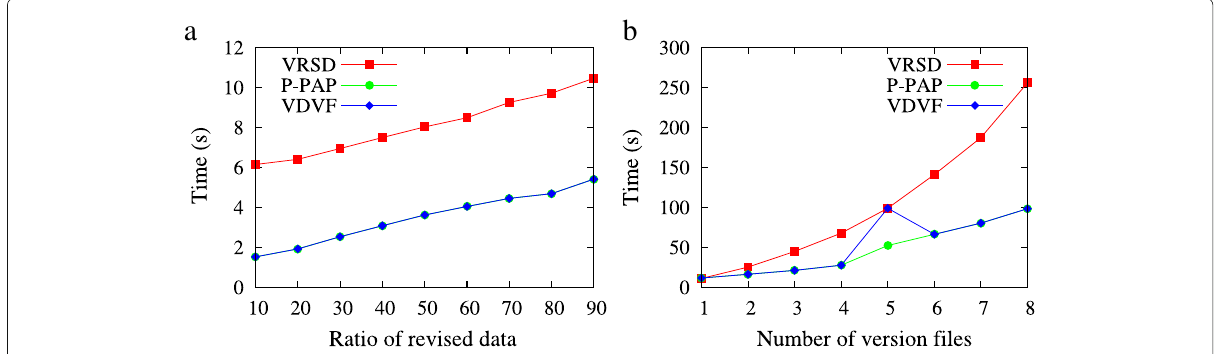
Fig. 8 Tag generation time. a different modification ratio. b different version number